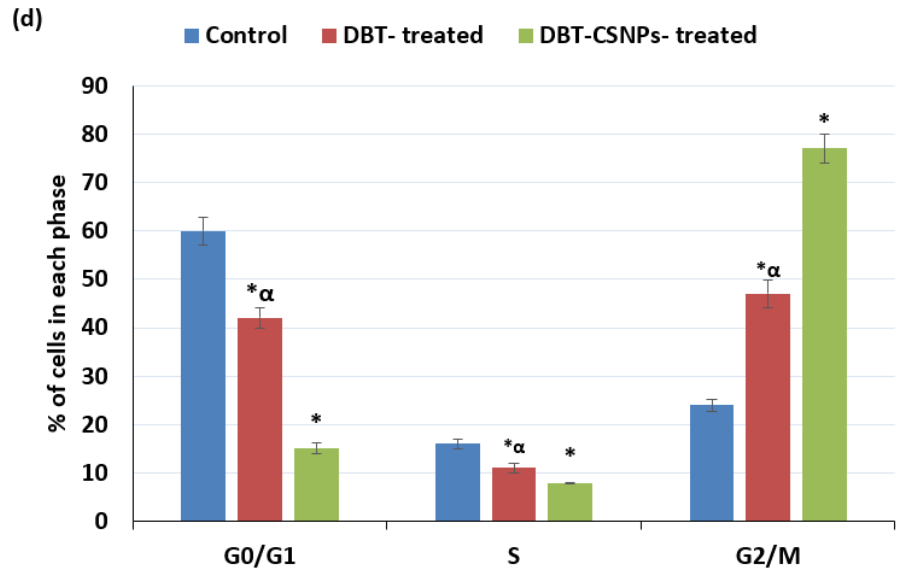
Figure 6. Flow cytometric analysis of control and treated HepG2 cells. ( a ) Control, ( b ) DBT-treated HepG2 cells, and ( c ) DBT–CSNP-treated HepG2 cells. The values represent the mean ± SD ( n = 3). ( d ) Represents % of cells in each phase. One-way ANOVA followed by Tukey’s test was used (* p < 0.05 versus saline control & α p < 0.05 versus DBT–CSNPs).